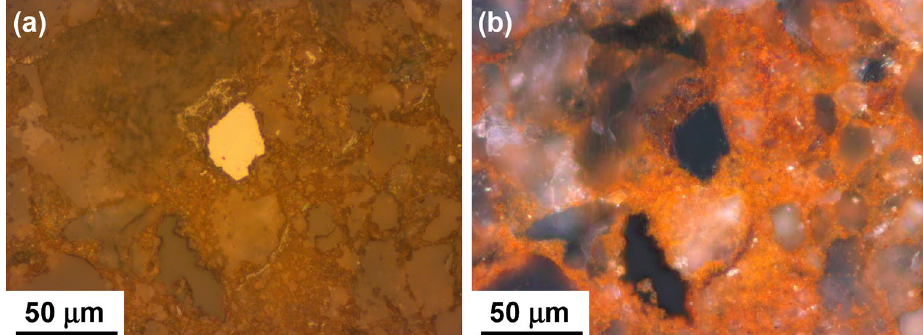
Fig. 6 Photomicrographs of sample HY4-3 in a plane and b polarized reflected light, showing hematite grain as detrital